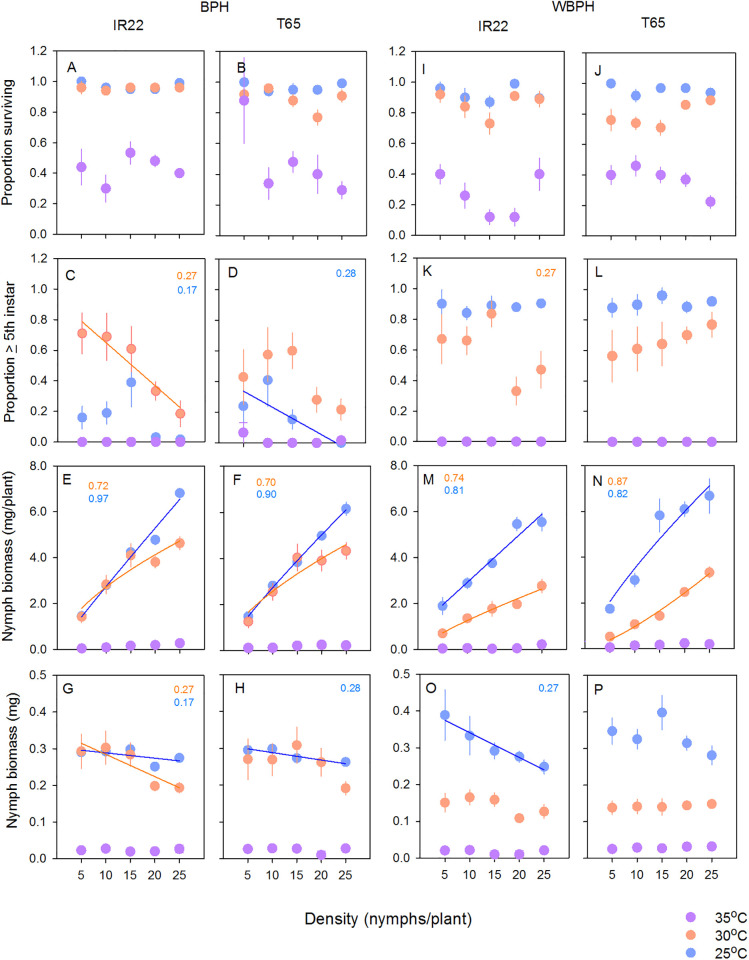
Relations between BPH (A-H) and WBPH (I-P) nymph densities and nymph survival (A,B,I,J), nymph development (C,D,K,L), the total weight of nymphs (E,F,M,N) and the average weights of individual nymphs (G,H,O,P). Nymphs were reared on IR22 (A,C,E,G,I,K,M,O) and T65 (B,D,F,H,J,L,N,P). Bioassays were conducted in environmental chambers set at 25°C (blue symbols), 30°C (orange symbols) and 35°C (purple symbols). Means are indicated with standard errors (N = 5). Numbers are R2 values for best fit models (as indicated; see S3–S5 Tables).